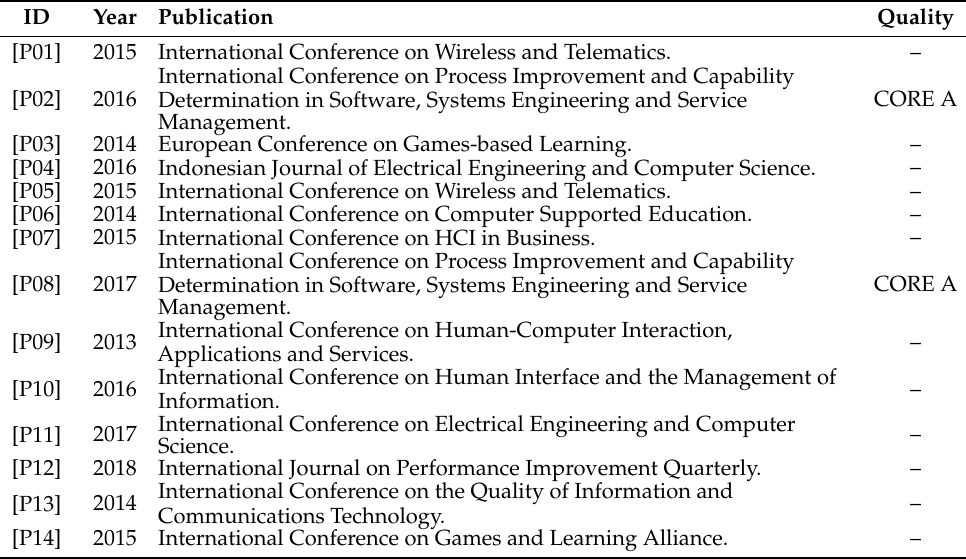
Table 9. Publication year and publication quality of the primary